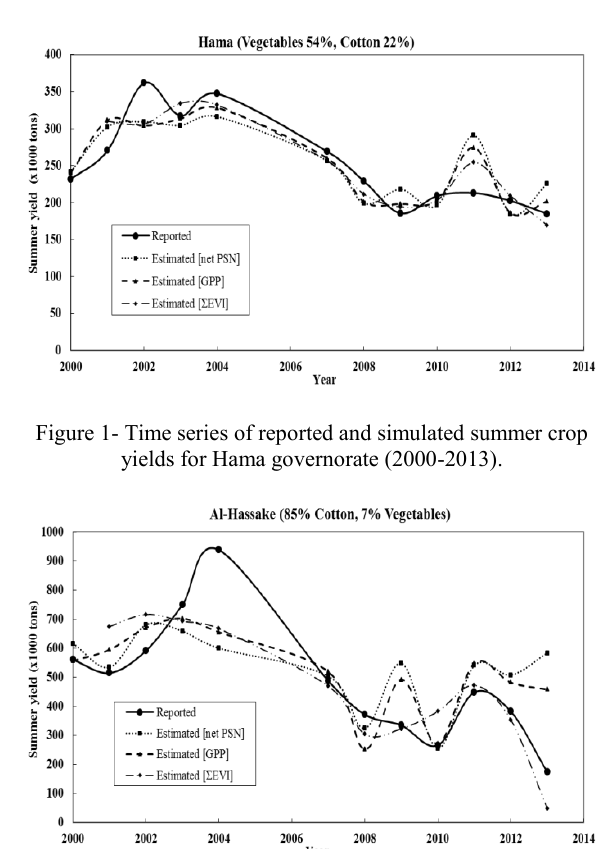
Figure 2- Time series of reported and simulated summer crop yields for Al-Hassake governorate (2000-2013).